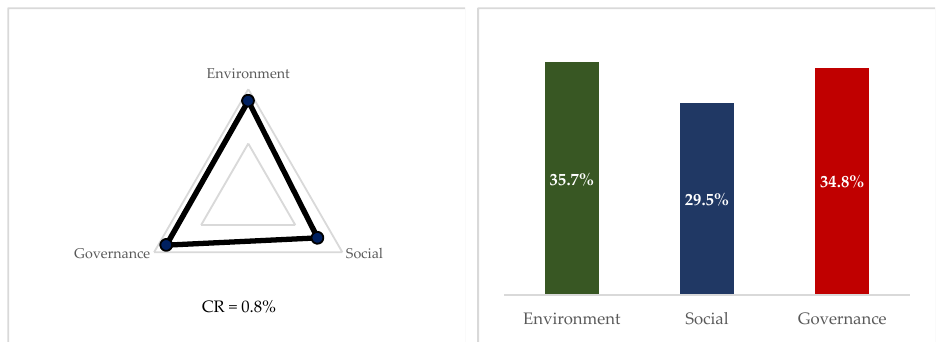
Figure 3. Local weights for level 2 (ESG).